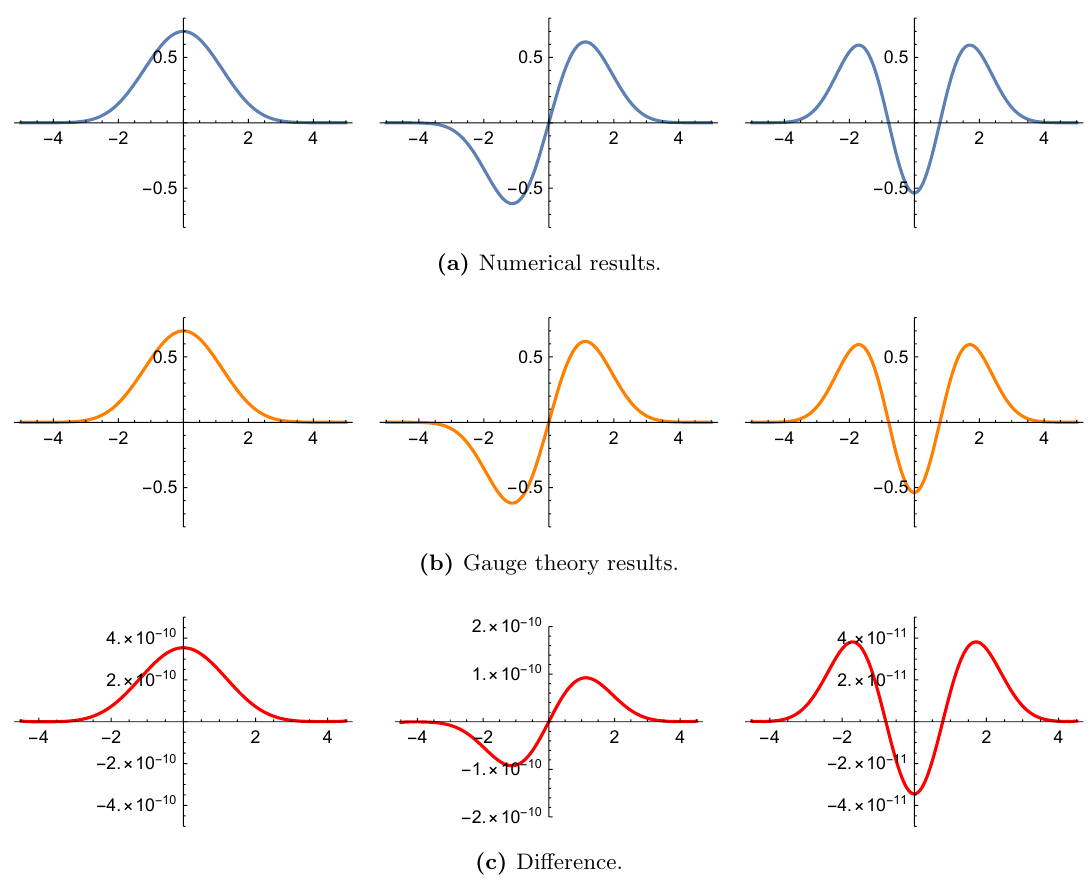
Figure 9. Level n = 0 ; 1 ; 2 2-particle Toda eigenfunction (cid:9) a ( x ) for Q = 1, ~ = 1 :